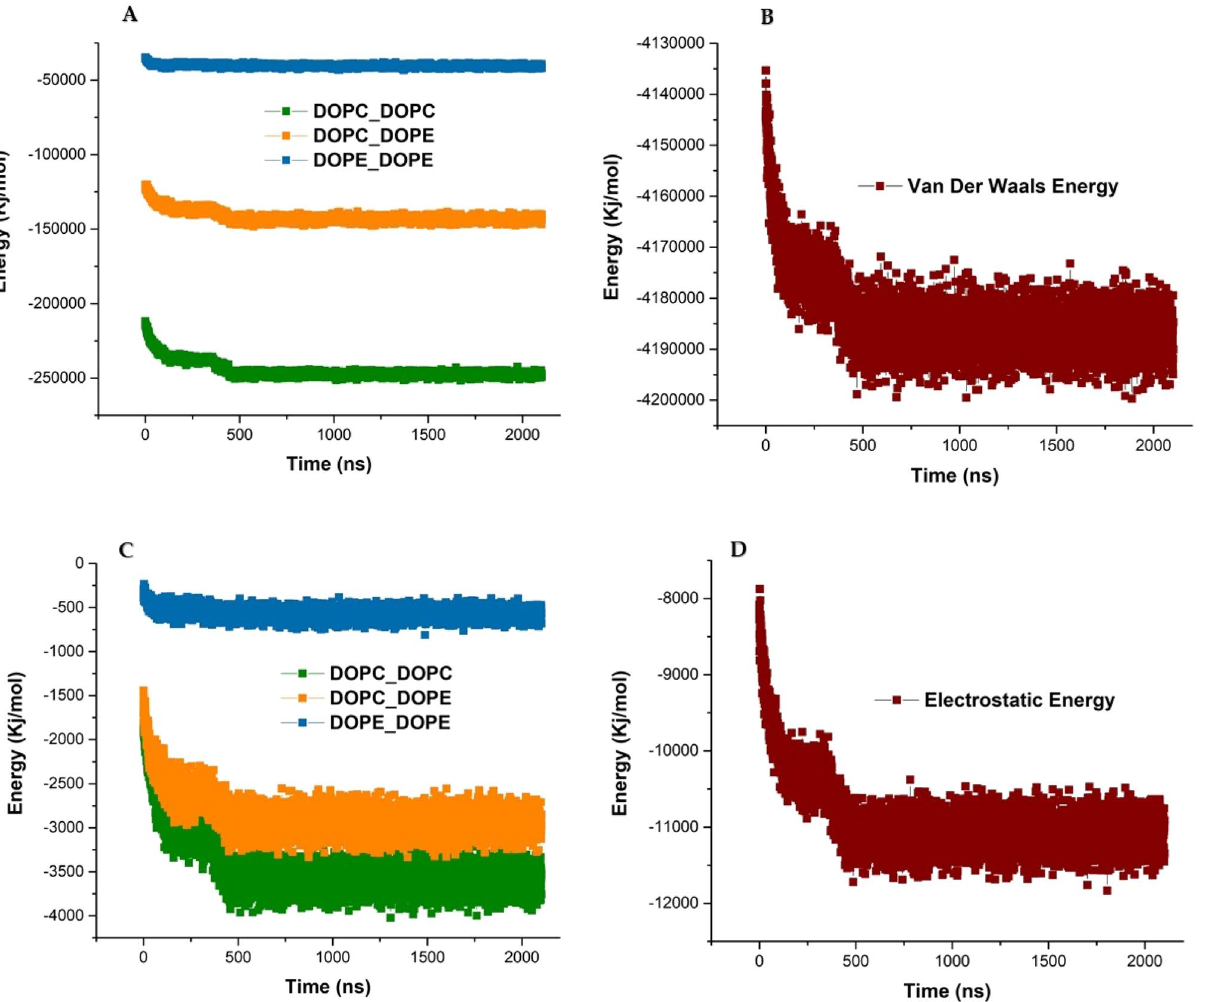
Figure 10. The energy of the van der Waals and electrostatic interaction of the simulated liposome structure. ( A ) Van der Waals interactions of pairs of DOPC–DOPC, DOPC–DOPE, and DOPE–DOPE. ( B ) Total van der Waals interactions of lipids. ( C ) Electrostatic interactions of pairs of DOPC–DOPC, DOPC–DOPE, and DOPE–DOPE. ( D ) Total electrostatic interactions of